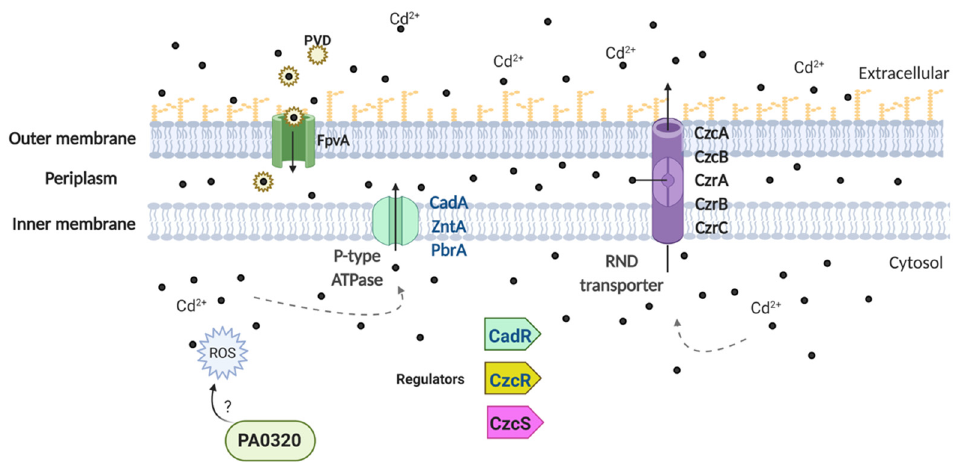
Figure 5. Schematic representation of the cadmium-resistance mechanisms based on the Pseudomonas genomes results. Protein names in blue are those found in the genome of Pseudomonas sp. GC01.